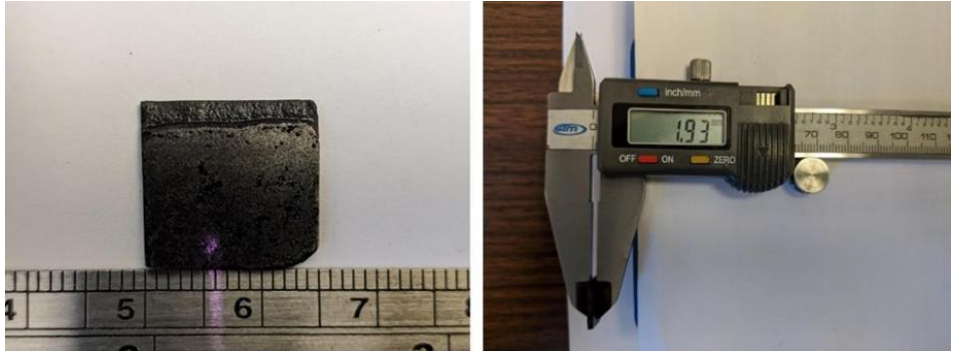
Figure 6. Appearance and dimensions of a single cured layer of 3D printed magnetic composite. Figure 7. Appearance and dimensions of a cut and smoothed 3D printed magnetic composite with three print layers.